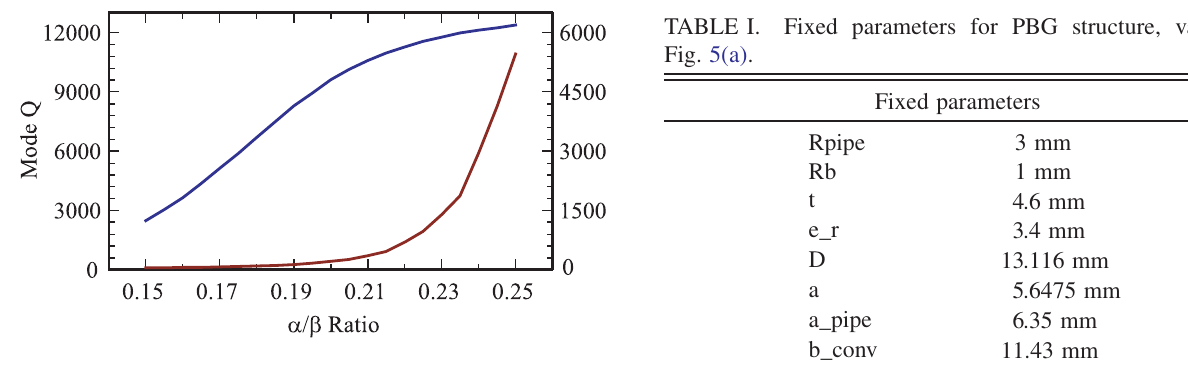
FIG. 4. Q of fundamental mode (blue, left axis) and dipole mode (red, right axis) as a function of (cid:1)=(cid:2) .